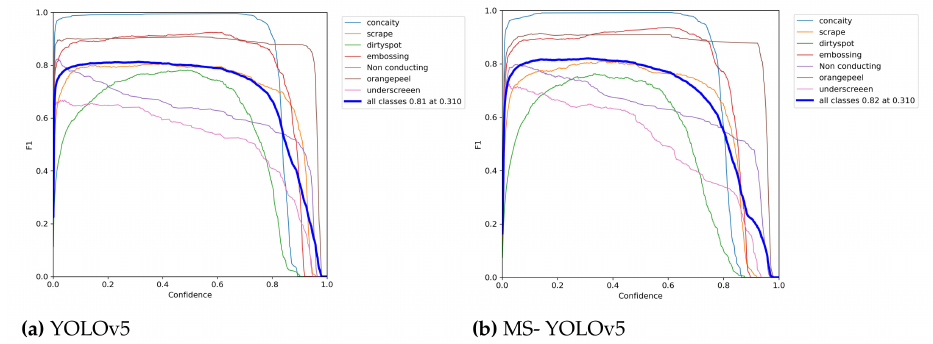
Figure 10. F1-Cure comparison of YOLOv5 and MS-YOLOv5 for seven different